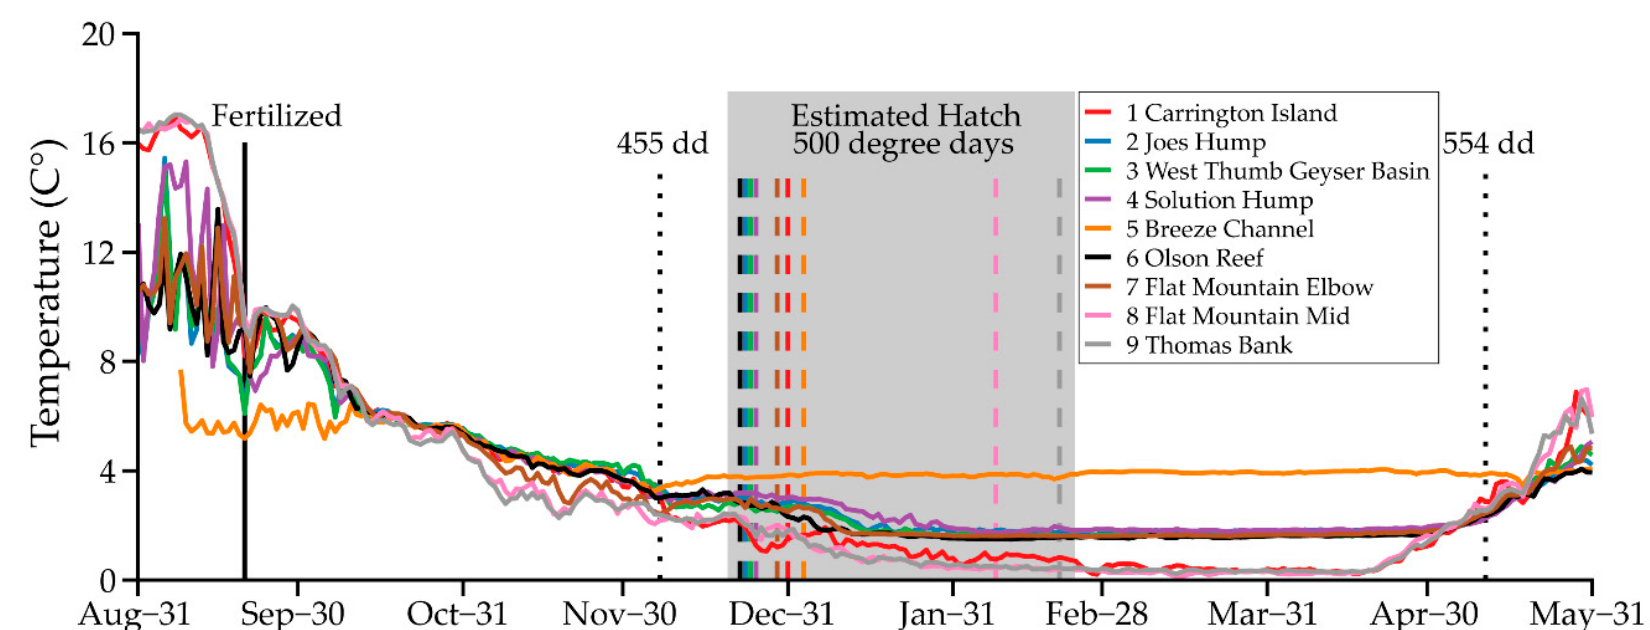
Figure 15. Water temperatures at the substrate of lake trout spawning sites in Yellowstone Lake during embryo fertilization, incubation, and hatching, September 2017–May 2018. Lake trout embryos require 455–554 degree days (dd) to hatch at 8 °C in the laboratory [147]. Dates of hatching at each site after 500 dd are within shaded gray. Although cooling temperatures slow development [148], embryos fertilized by 20 September may hatch prior to Yellowstone Lake becoming ice covered in late-December, many months earlier than within their native range in the Great Lakes [149].